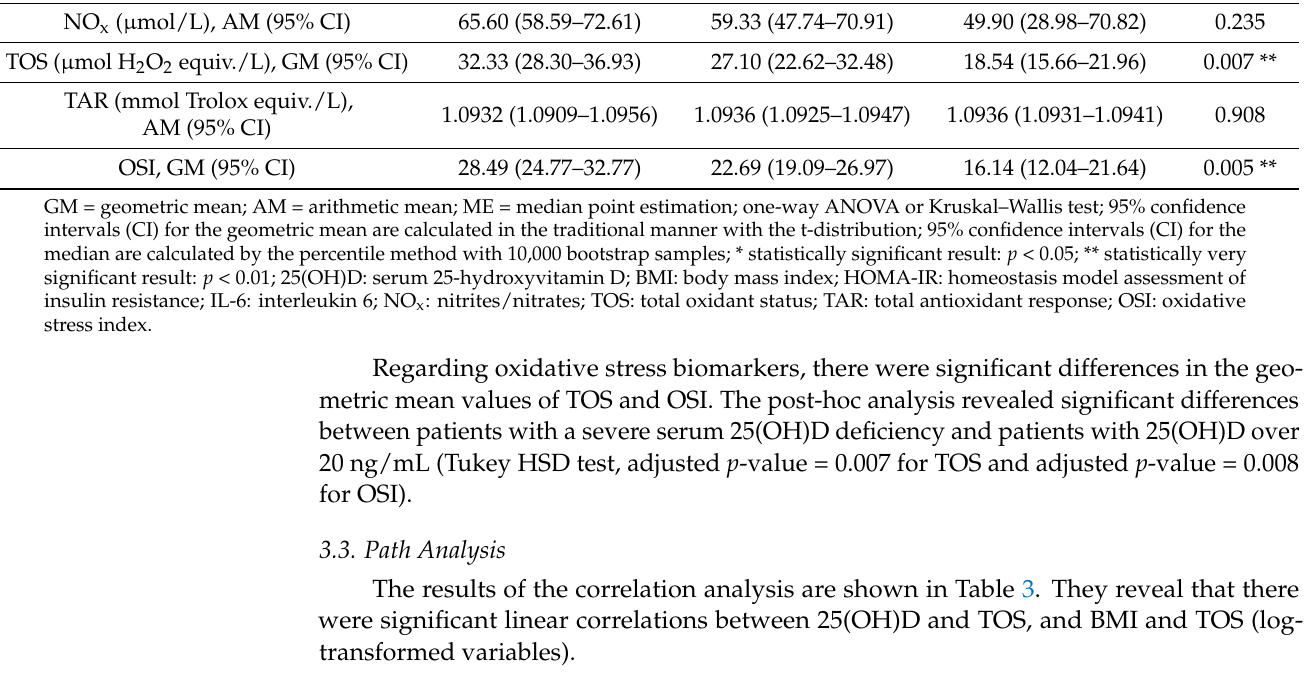
Table 3. Matrix of the Pearson correlation coefficient ( p -values) among studied